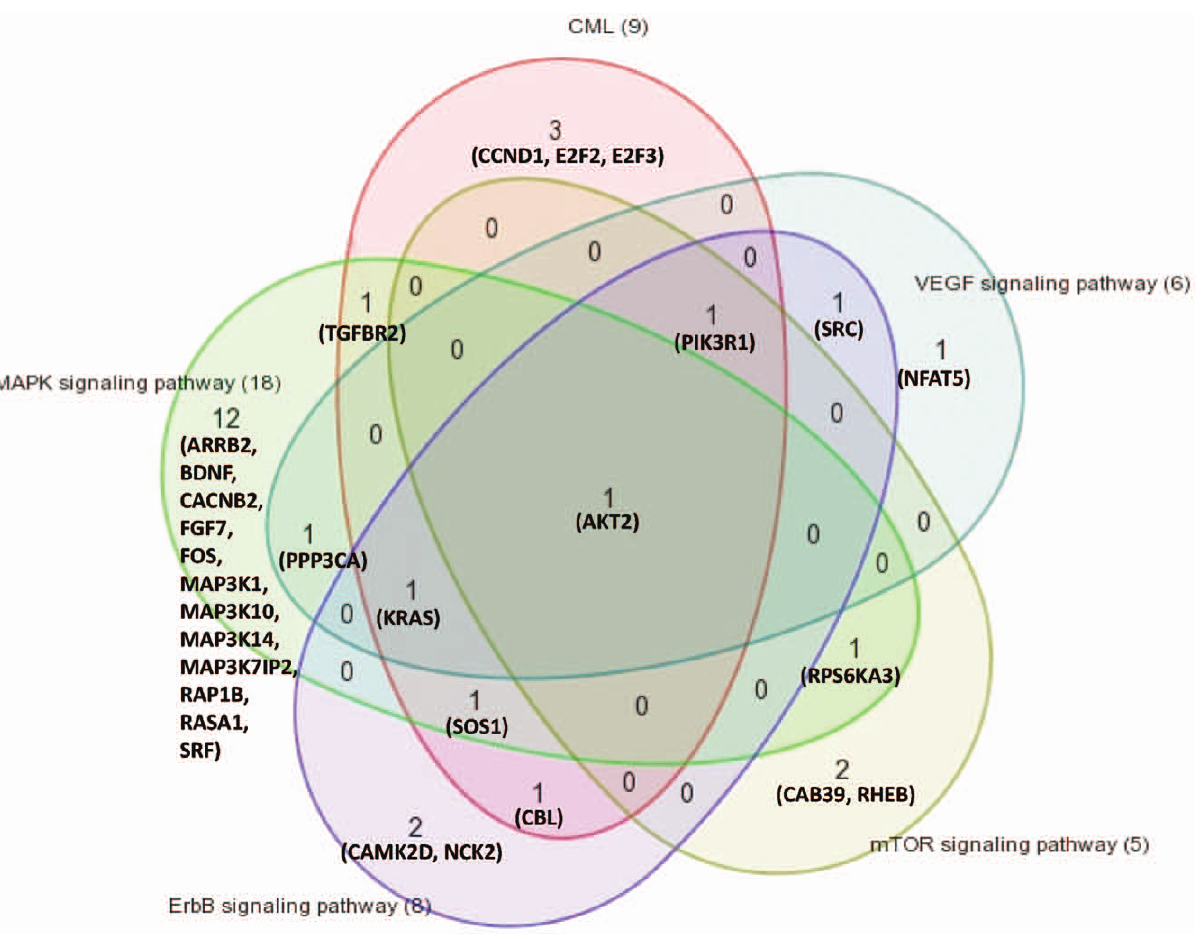
Figure 7. Overlap of predicted target genes. A Venn diagram showing the overlap between predicted targets of CML-related miRNAs and miRNAs related to the different pathways that are predicted to be deregulated in our study.